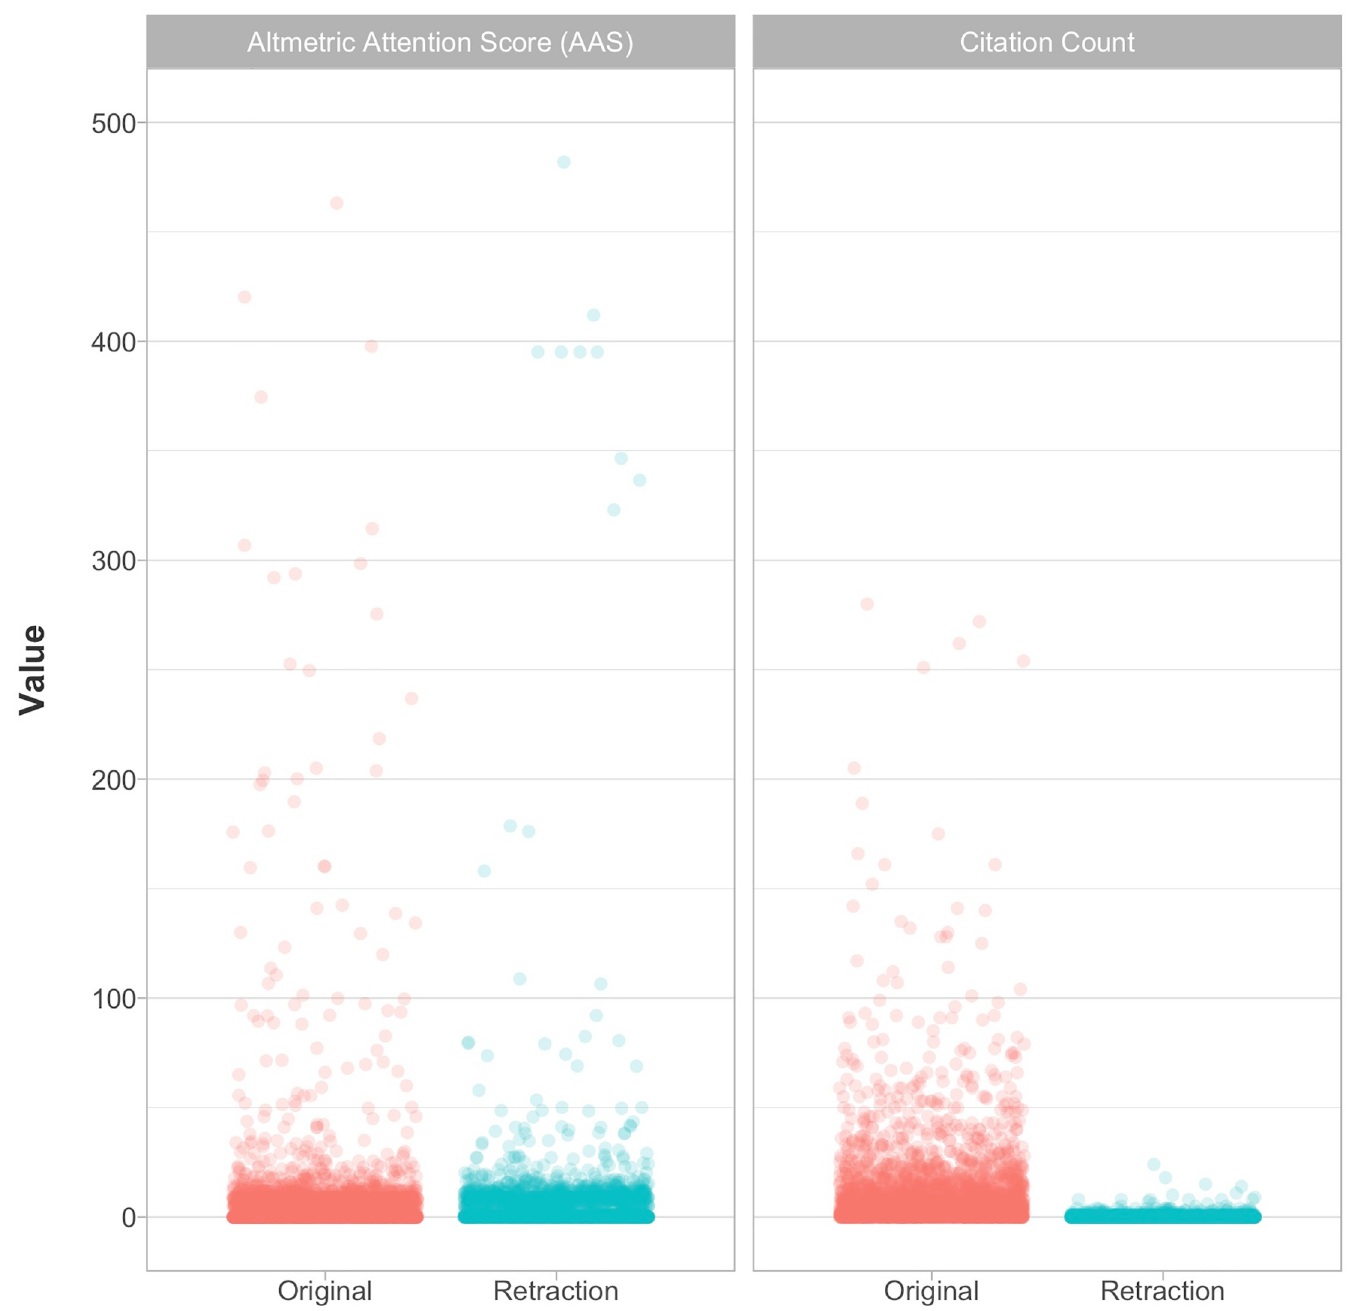
Fig 2. AAS and citation count across original articles and retraction notices. The distribution of AAS between 3,097 original articles and their retraction notices is fairly similar. However, a small number of original articles tend to receive more extreme AAS scores (5 articles with very high original AAS (Range, 1019–3166) are not shown for clarity). Unlike AAS, the citation count in 3,008 original articles is far greater than that in their retraction